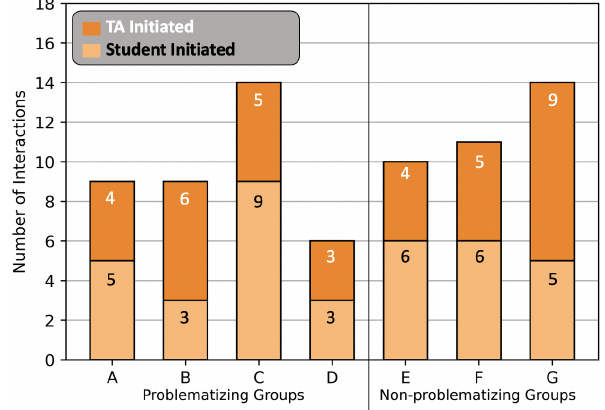
FIG. 9. The number of interactions with the TA is lowest for group D, which did problematize, and highest for groups C, which did problematize, and G, which did